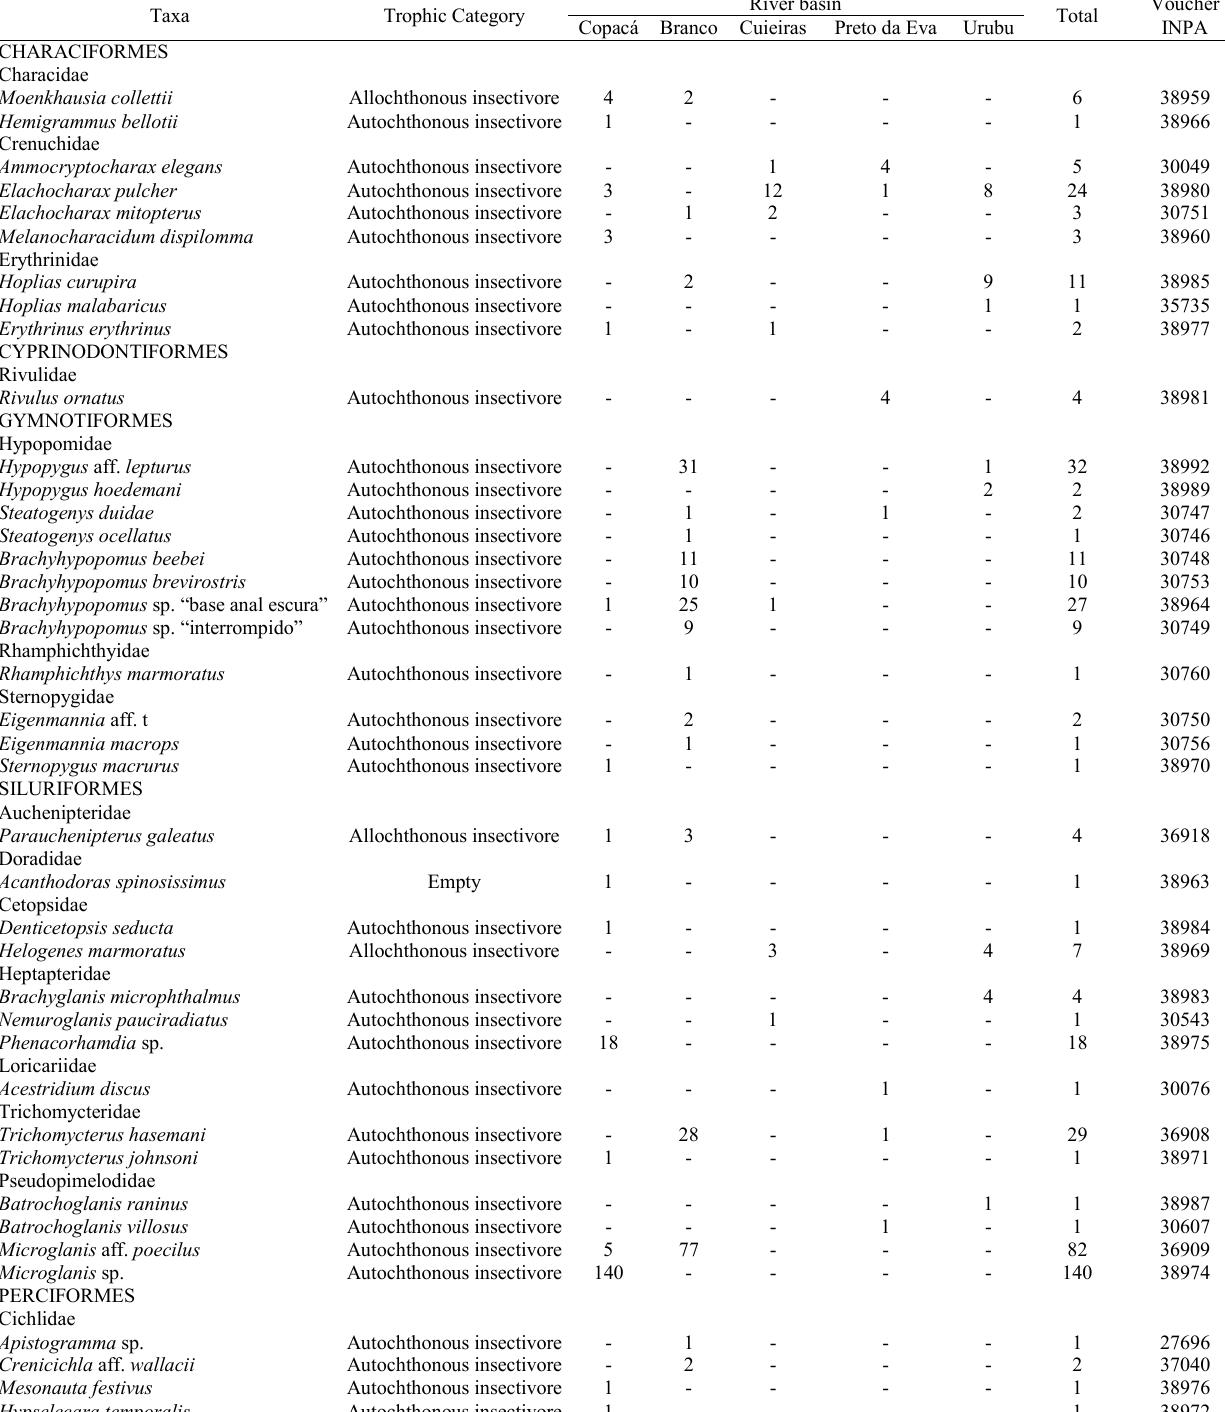
Table 1. Species composition, abundance, and trophic categories of fishes in the floating litter banks samples of 4 th and 5 th order streams of five river basins in the Brazilian